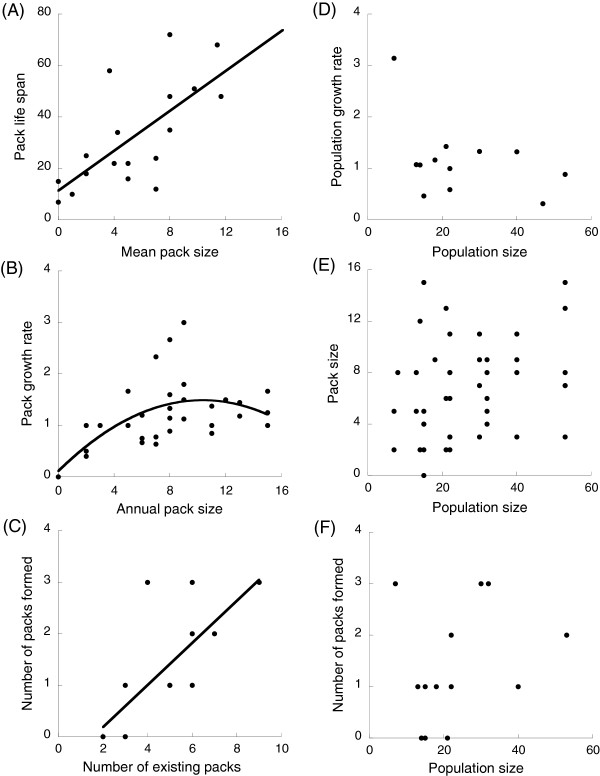
Relationships between pack and population performance and pack and population size in Lycaon. (A) pack life span in months, (B) annual per capita pack growth rate, (C,F) number of pack creation events per year, (D) annual per capita population growth rate and (E) annual pack size. Circles represent observed values for each pack (A), for each pack in each year (B, D) and for each year (C); model fits revealing group and demographic Allee effects are shown when statistically significant. Fits correspond to a simple linear regression of raw data, not to the fits for the generalized linear models.